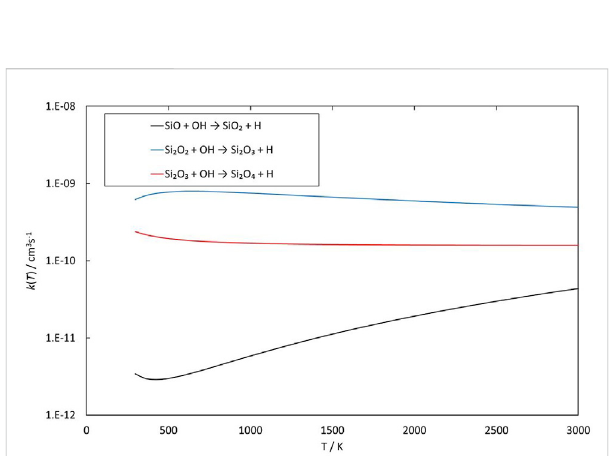
FIGURE 8 Potential energysurfacebasedonM06 calculationsfor theSiO+ OH reaction as implemented in the RRKM calculations. The energies are given in kJ/mol and include zero-point energy corrections. The dashedlineindicatesthatthereactionstephasbeensimpli fi edby combining similar intermediate isomers.